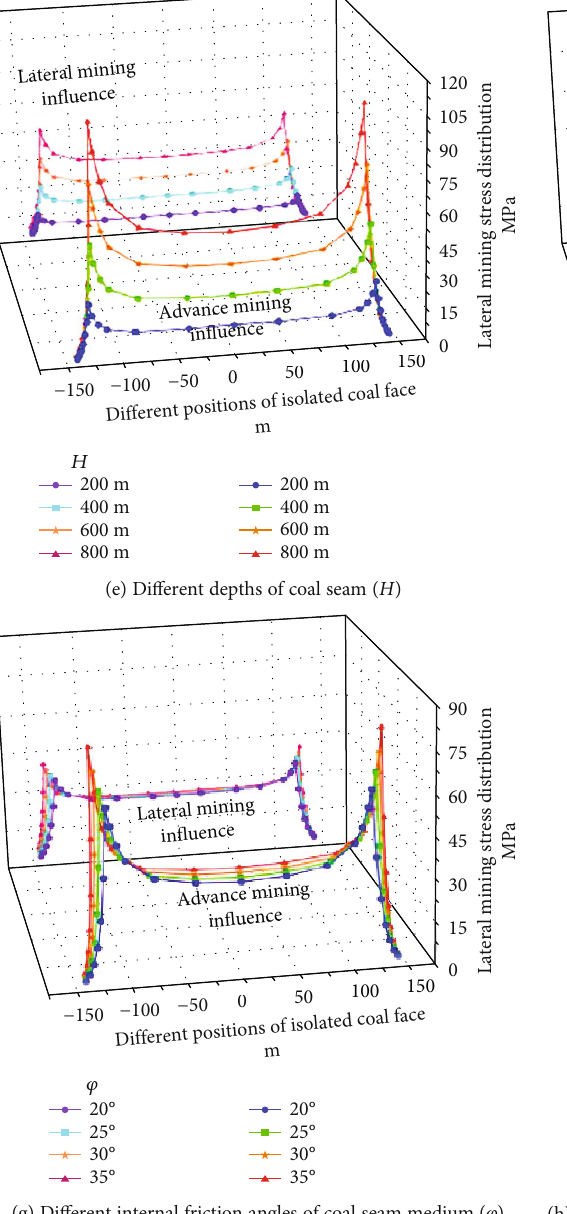
Figure 13: In fl uence characteristics of various factors on mining stress of isolated island